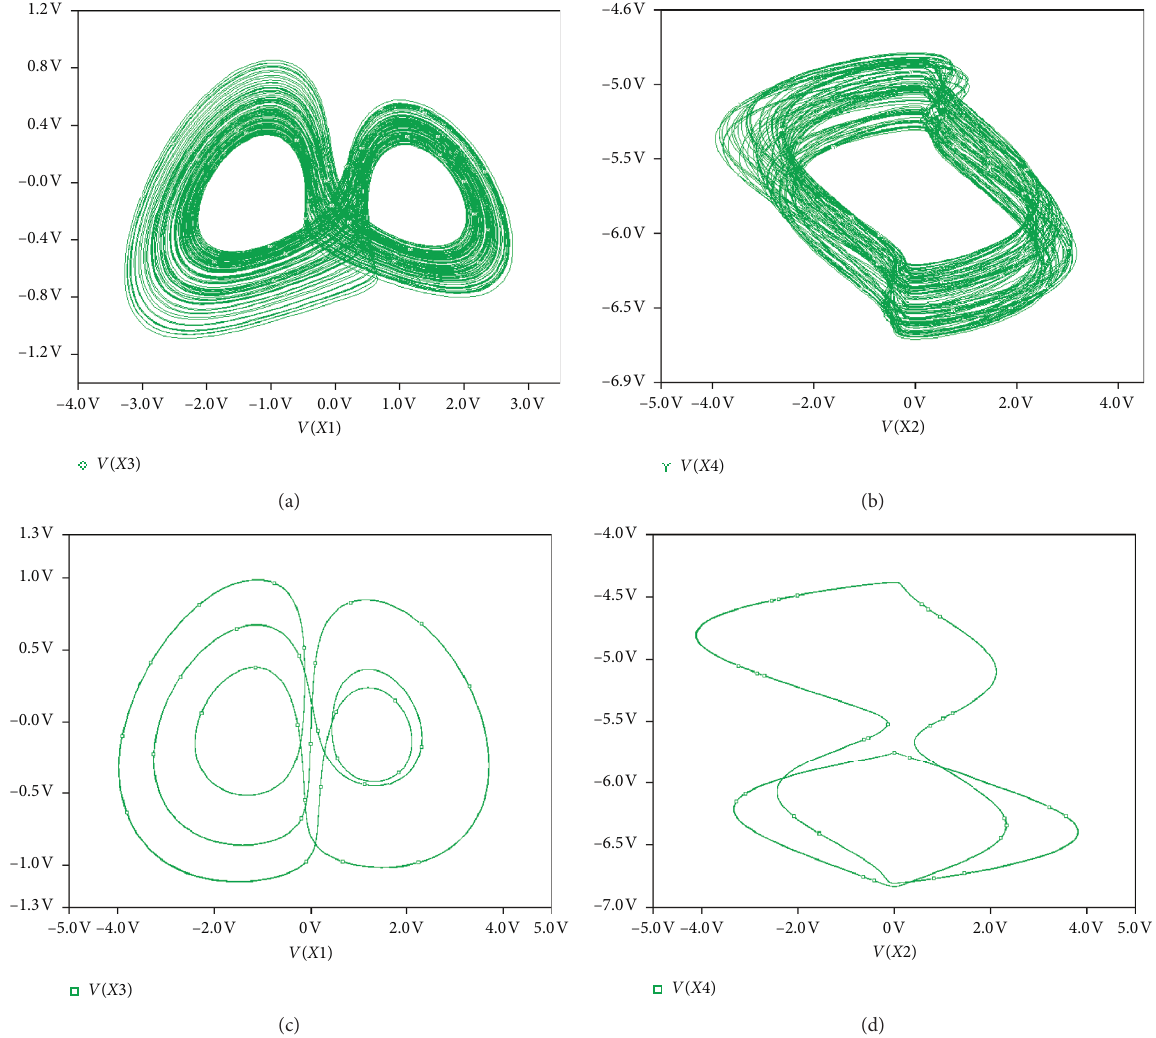
Figure 12: Quasiperiodic motion observed for R motion observed for R a � 2 . 65 k Ω , R